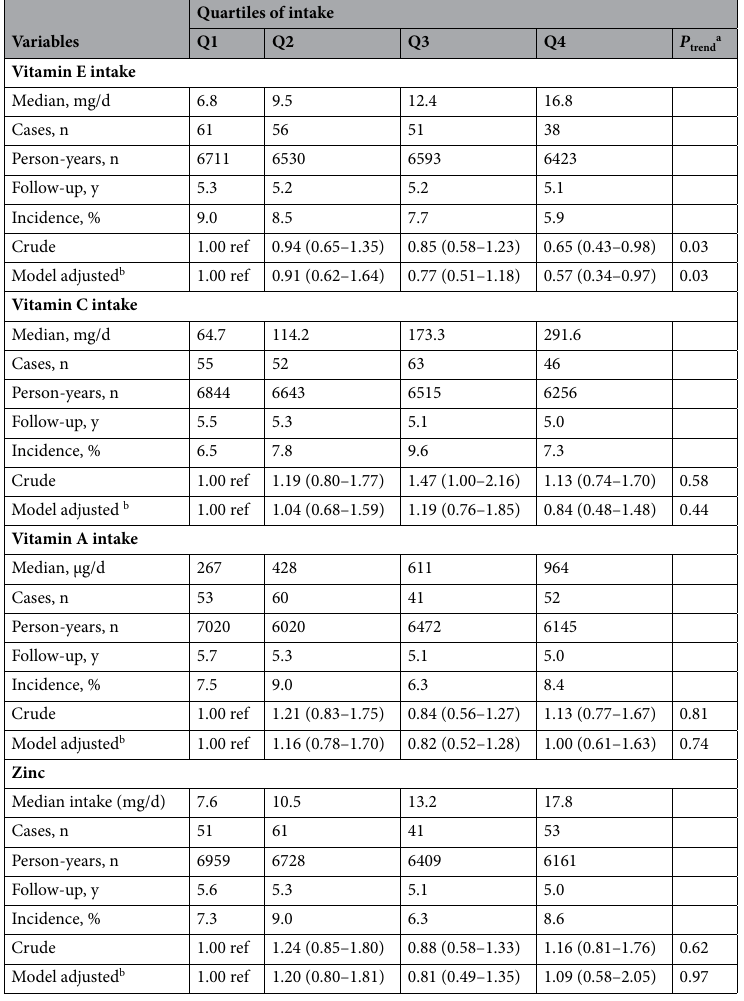
Table 3. Hazard Ratios (HR) and 95% CIs for cardiovascular diseases according to quartiles of dietary antioxidants intake. a Test for trend based on ordinal variable containing median value for each quartile. b Adjusted for age, sex, CVD risk score, family history of CVD, physical activity, total energy intake, fiber and total fat